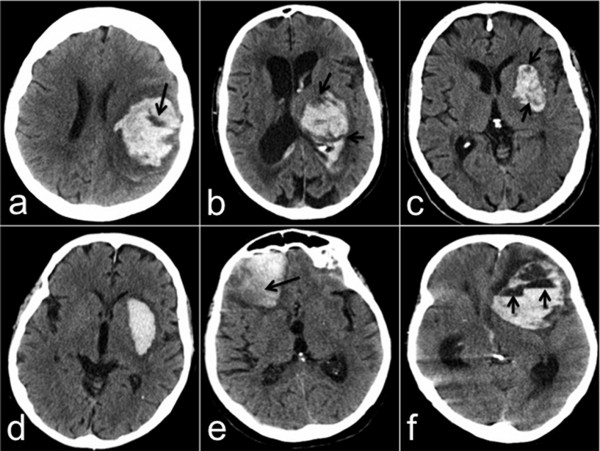
Different examples of swirl sign and swirl sign mimics. Axial images of 6 different patients with ICH. (a–c) Show different forms of swirl sign; well defined in a, irregular in b, and streak-like in c. (d) Shows homogeneously hyperattenuated left-sided putaminal haemorrhage with no swirl sign. (e) Shows right-sided subacute frontal haemorrhage with lower attenuation (black arrow) at the outer posterior portion indicating beginning resorption (clot retraction) that should not be addressed as swirl sign. (f) Shows left-sided subacute frontal haemorrhage with multiple blood-fluid levels (short arrows) that should not be addressed as swirl sign.